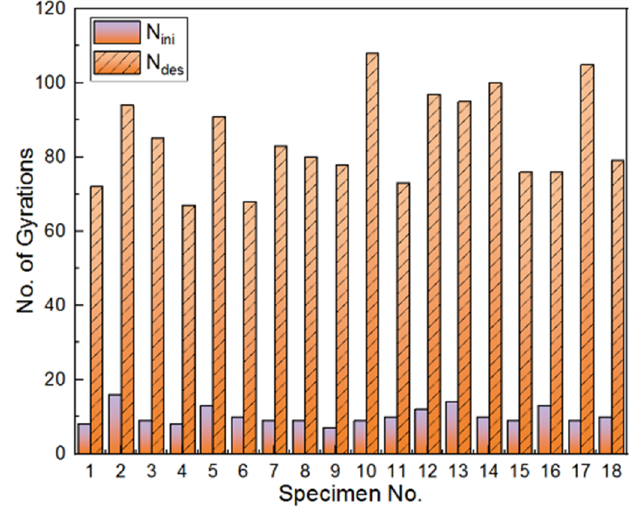
Figure 11. The histograms of the initial number (Nini) and design number (Ndes) of gyrations identified for different specimens in the orthogonal array matrix.